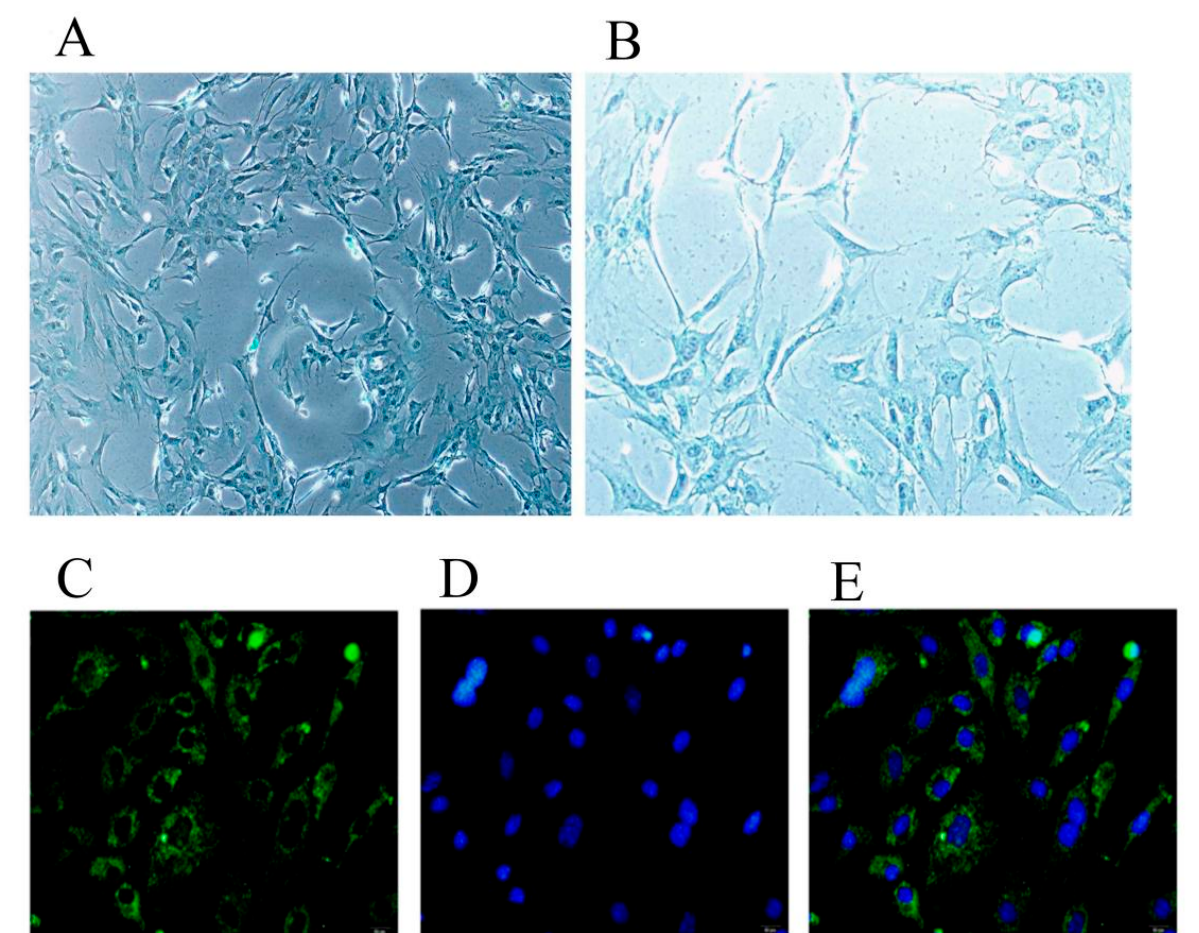
Figure 1. Identification of the purity of chondrocytes. ( A ) Chondrocytes were identified by Alcian Blue staining (magnification, ×100). ( B ) Chondrocytes were identified by Alcian Blue staining (magnification, × 200). ( C – E ) Chondrocytes were identified by the immunocytochemistry staining of type II collagen. ( C ) Type II collagen; ( D ) DAPI; and ( E ) the merged image (magnification, ×200).